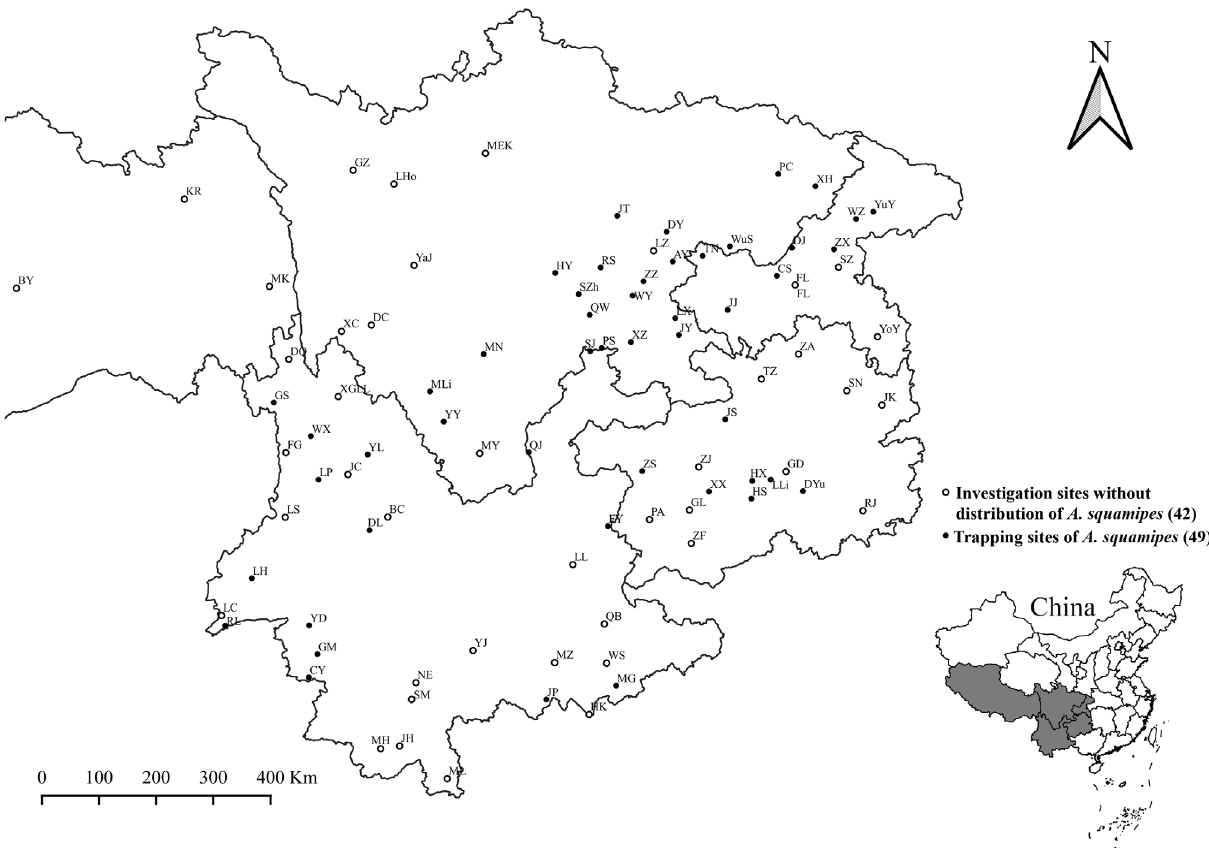
Figure 1. Investigation sites ( n = 91) in Southwest China between 2001 and